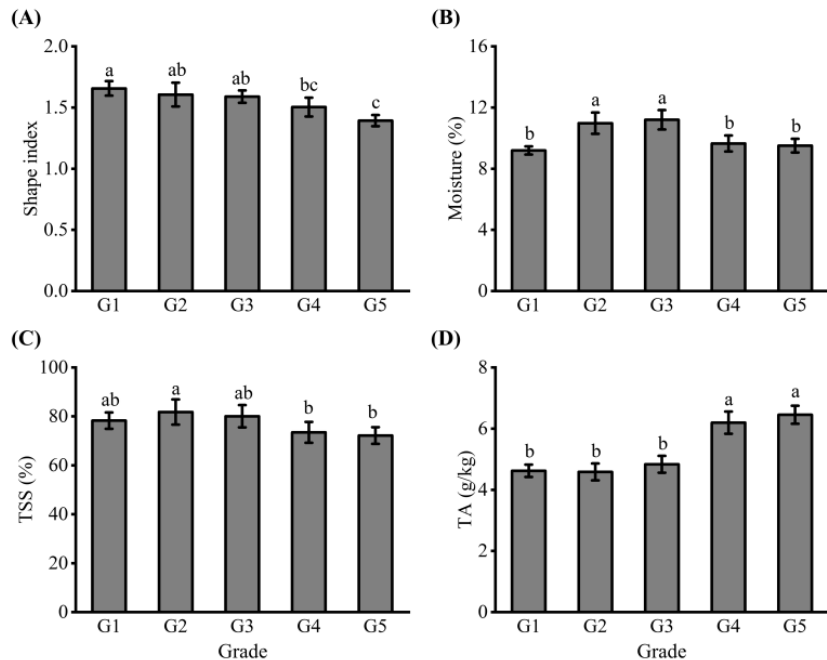
Figure 1. The quality attributes of dried jujube. The analysis of ( A ) shape index, ( B ) moisture, ( C ) total soluble solids (TSS), and ( D ) total acidity (TA) of dried jujube. The dried jujubes were arranged in the order from large to small, which were G1, G2, G3, G4, and G5 groups, respectively. Data are expressed as means ± standard deviation (SD) from three replications. Means with different letters are significantly different ( p < 0.05).